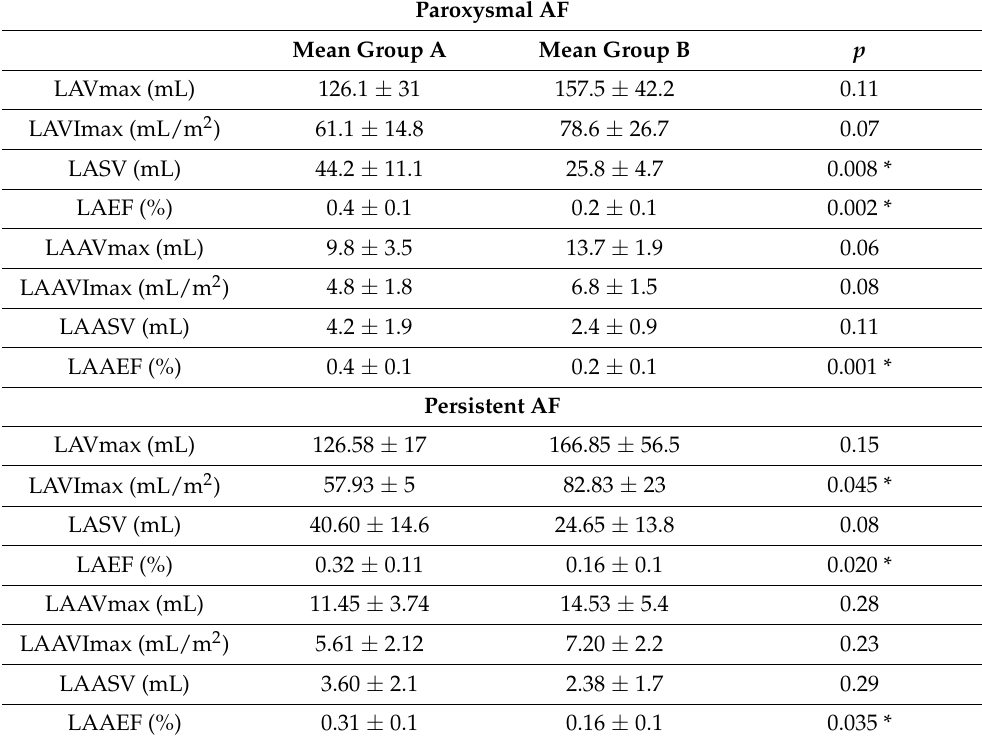
Table 3. Morphological and functional cardiac CT parameters separated into subgroups of paroxys- mal and persistent AF (group A: non-recurrence, group B: AF recurrence). Significant differences marked with